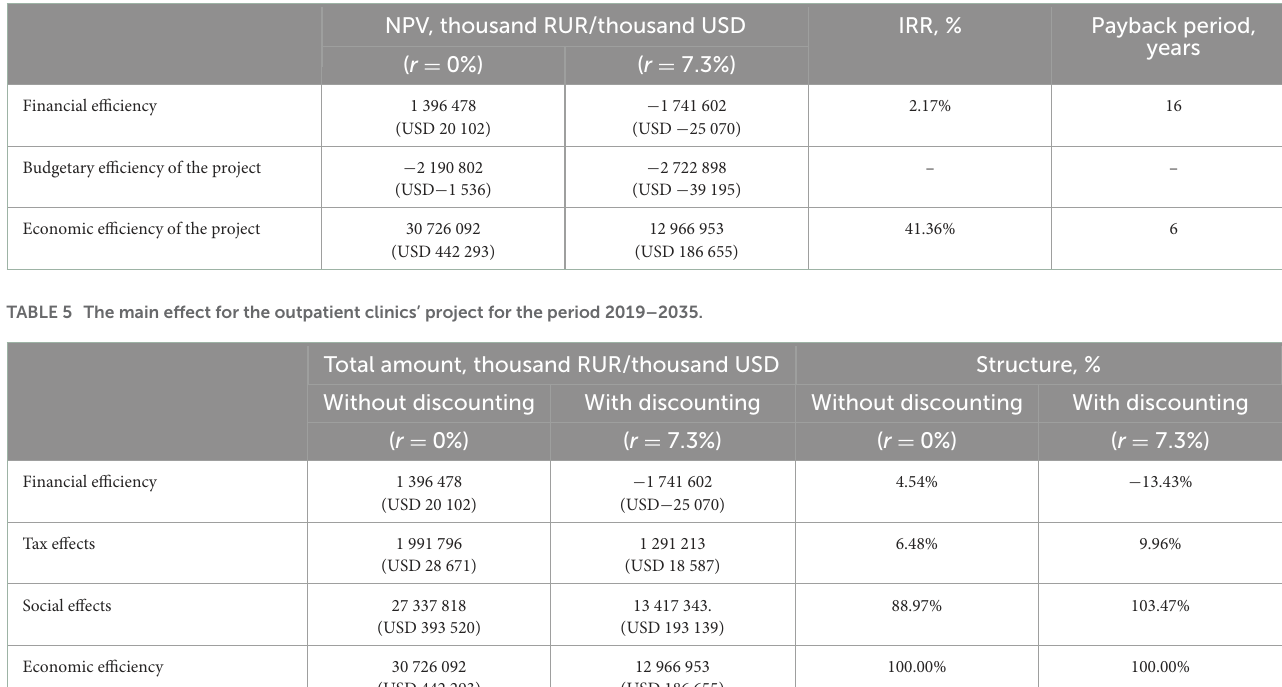
TABLE 4 The main efficiency indicators for the outpatient clinics’ project for period 2019–2035.